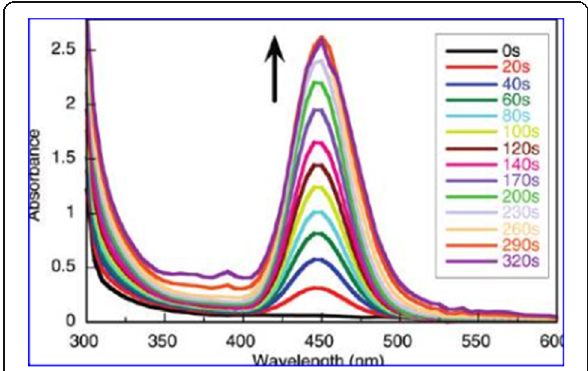
Fig. 15 UV-vis absorption spectra following irradiation (350 nm, four lamps) of a toluene solution containing 2 mM silver trifluoroacetate, 2 mM I-2959, 2 mM cyclohexylamine. Reaction performed and monitored directly in a 0.7 × 0.3 cm quartz cuvette